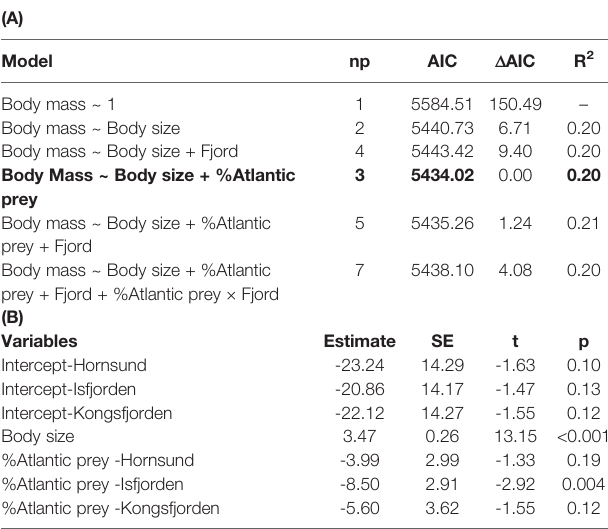
TABLE 5 | Effect of the individual proportion of Atlantic prey in the little auk (chick) diet on body mass of adult little auk breeding in three western Svalbard fjords (Hornsund, Isfjorden and